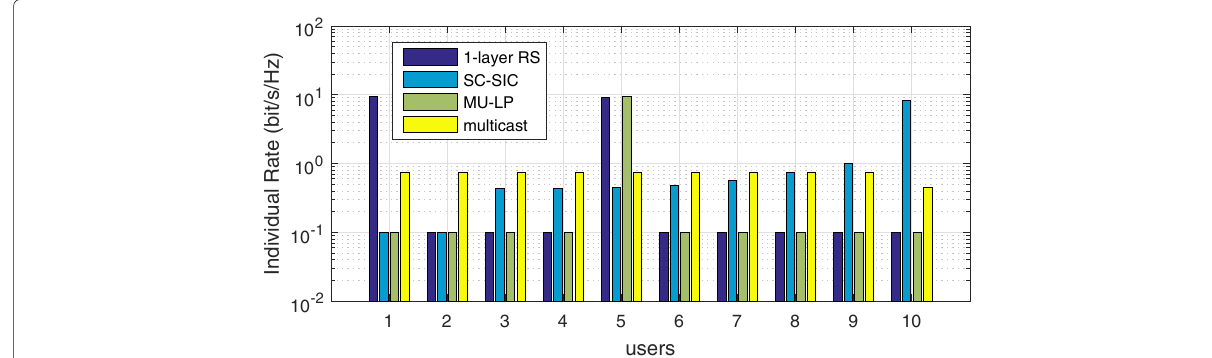
Fig. 21 Individual rate comparison of different strategies for overloaded ten-user deployment with perfect CSIT for 1 randomly generated channel estimate, SNR = 30 dB, N t = 2, r th = [0.01,0.03,0.05,0.1,0.1,0.1,0.1]